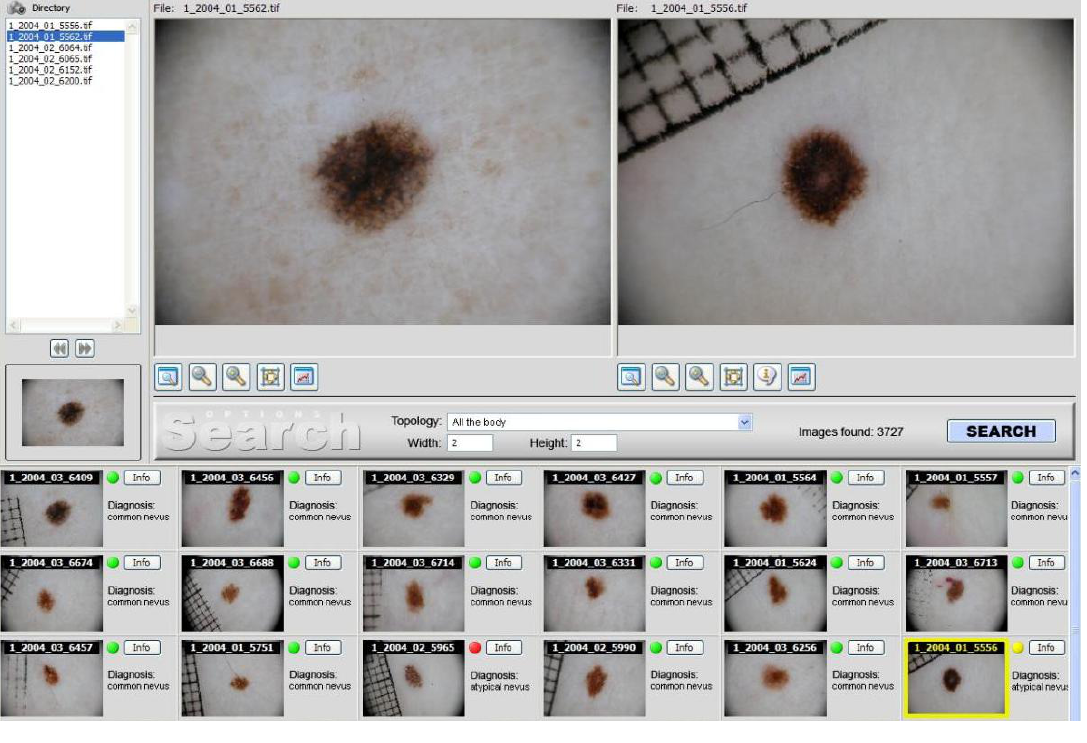
Figure 1. FIDE graphical user interface. The query image on the upper left is compared to those in the archive. Most similar results by image content are returned in the lower thumbnail pane together with their respective biopsy diagnoses (red dots for unfavorable outcomes, green ones for normal ones). Single images chosen from the returned set can be visually compared with the query by double-clicking their thumbnails, loading their original in the view panel on the upper